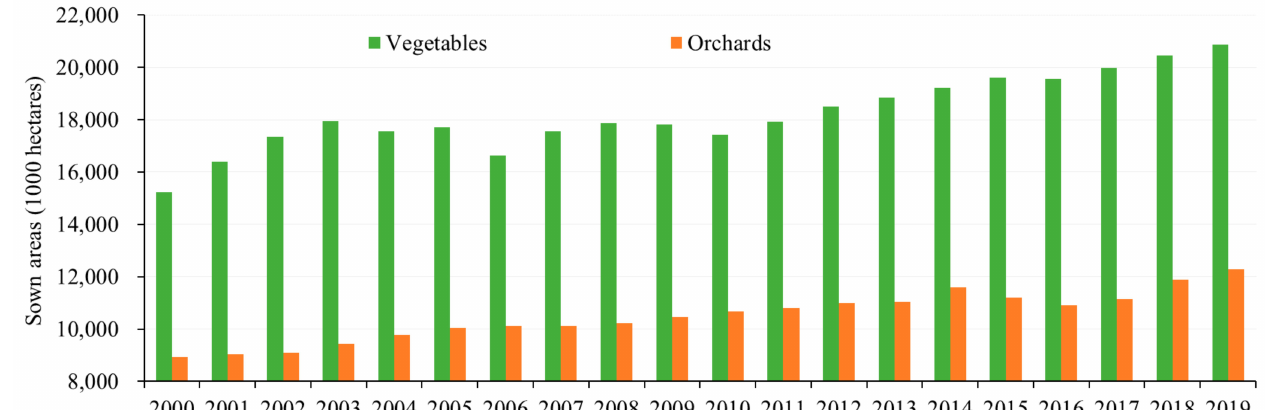
Figure 5. Changes of the sown areas of vegetables and orchards in China from 2000 to